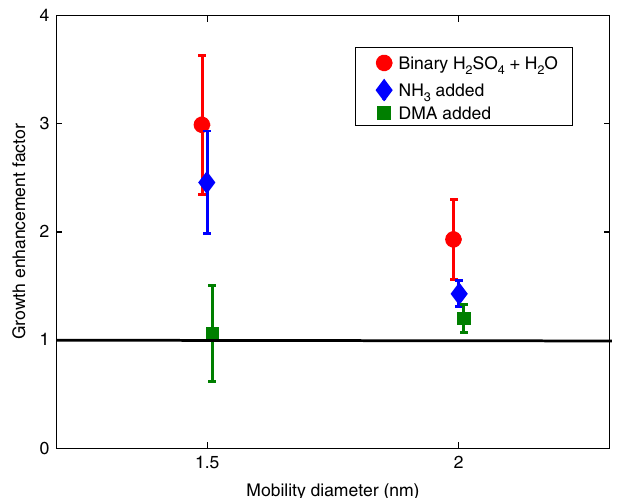
Figure 3 | The effect of ions. The growth enhancement factor (GEF) due to the presence of ions in the chamber as a function of diameter in different systems. The GEF was determined as the ratio of the growth rate of the total particle population in a charged run and an identical neutral run. Each data point is at the mean value of all the experiments for which the GEF was possible to determine for the given system. Error bars give the s.e.m. The black line shows the case with no growth enhancement. Note that the magnitude of the enhancement is also dependent on the charged fraction of the particle population.